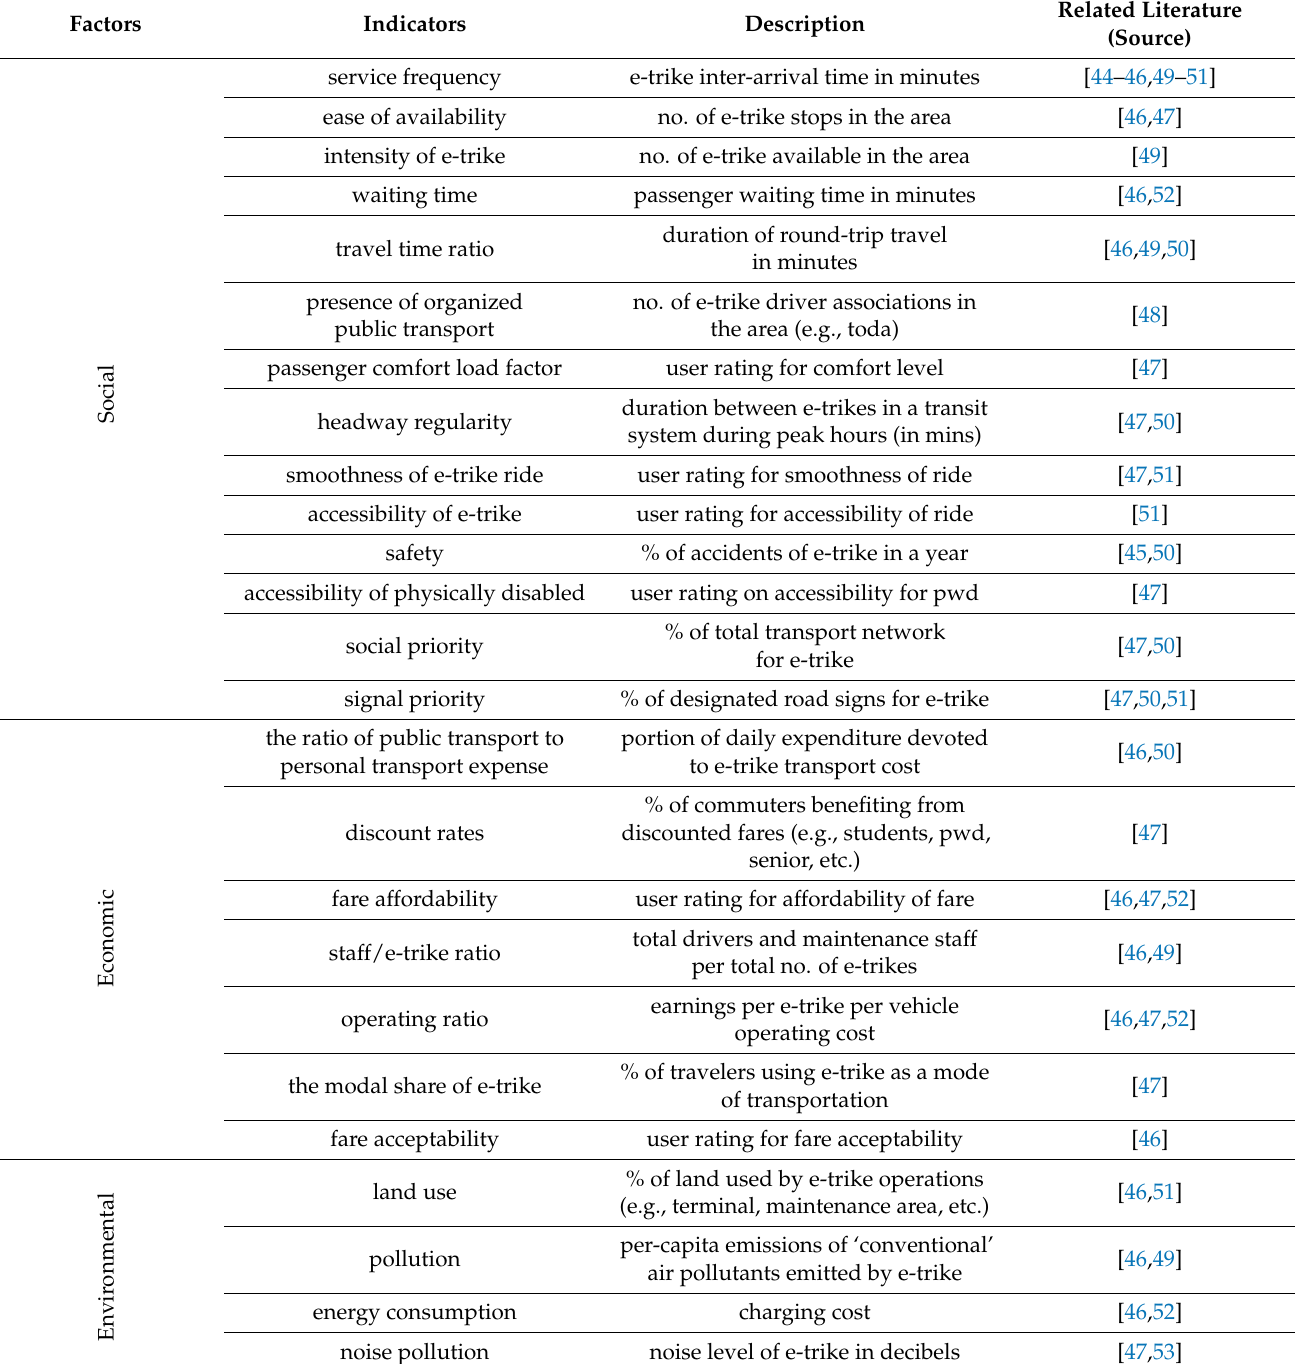
Table 1. Summary of indicators for sustainability